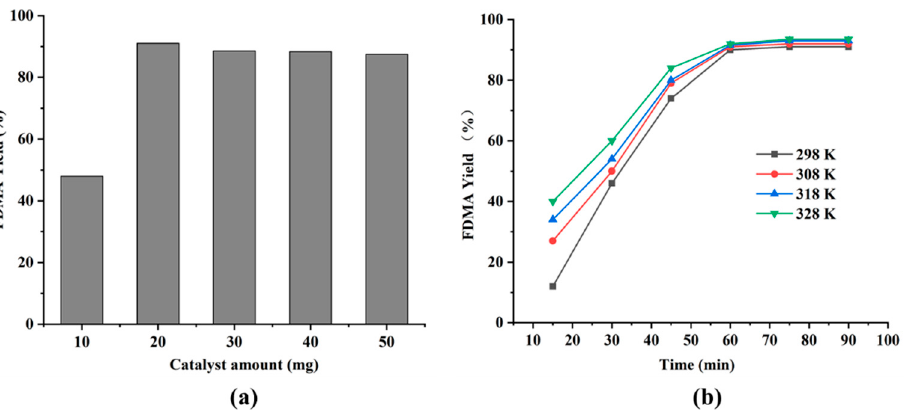
Figure 7. ( a ) The influence of MCS catalyst amount on the yield of FDMA synthesized from FUR acetalization. ( b ) The influence of temperature on the yield of the FDMA. Reaction conditions: 96 mg FUR (1 mmol), 3 mL methanol (74 mmol), room temperature for 1